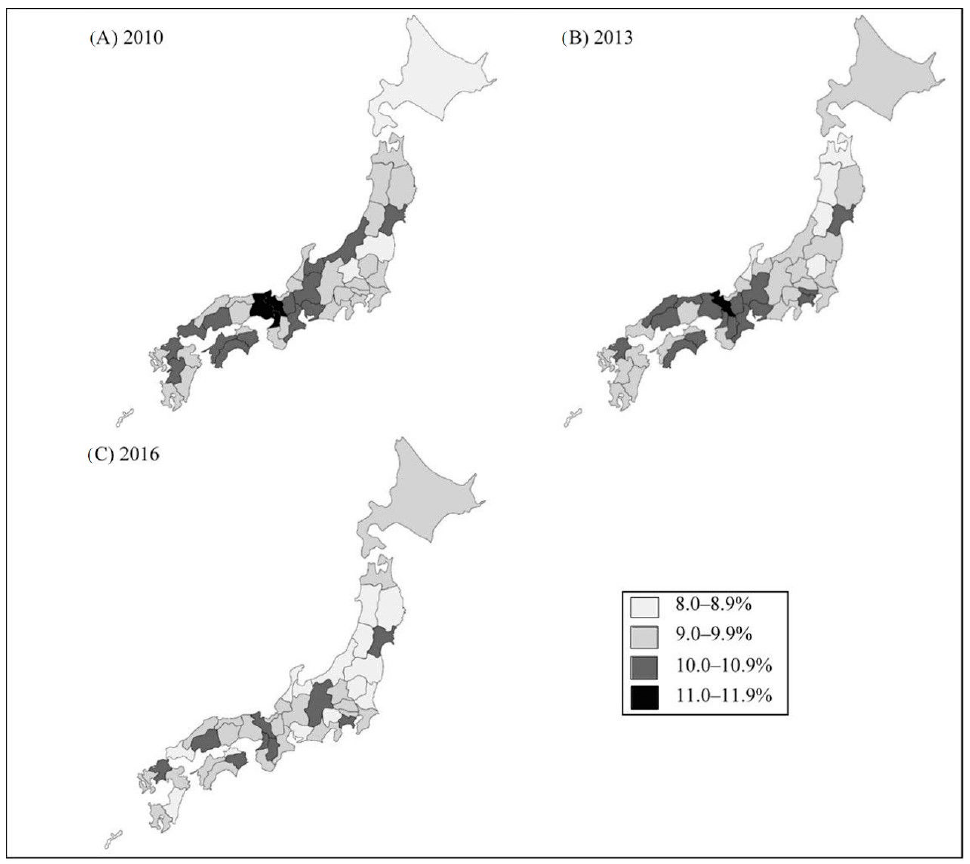
Figure 3. Prevalence of lower back pain and unemployment according to year of investigation and prefecture. ( A ) the 2010 survey; ( B ) the 2013 survey; ( C ) the 2016 survey. In the 2016 survey, data of Kumamoto Prefecture was not collected due to a huge earthquake in 2016.